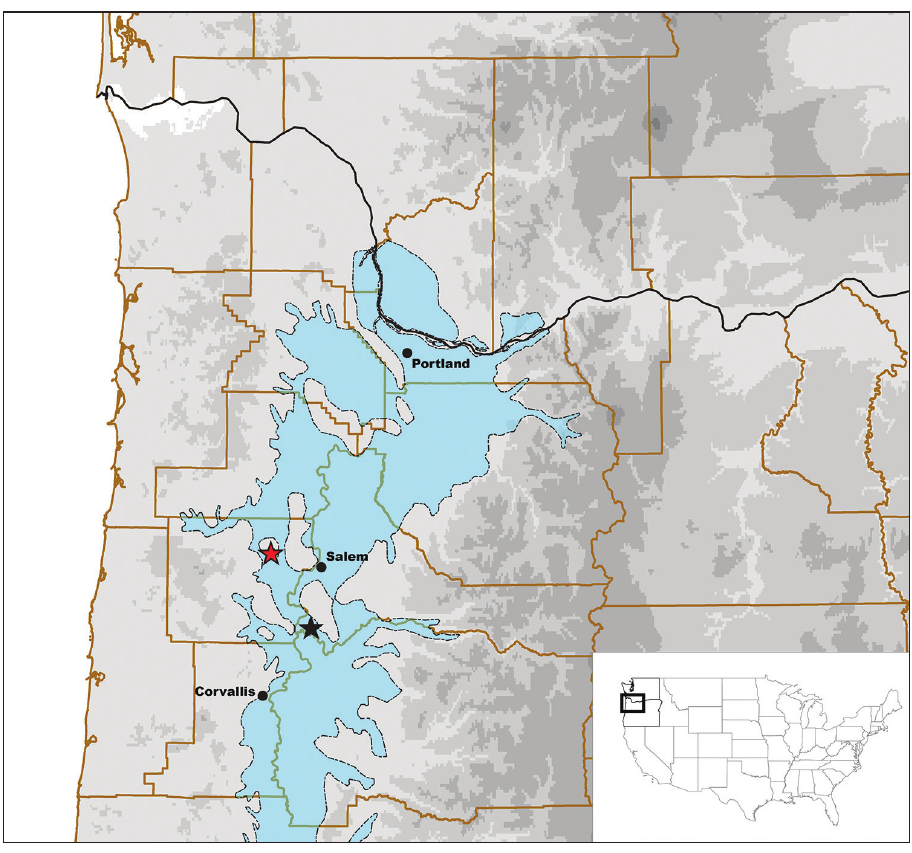
Figure 2. The two known collection localities of Stygoporus oregonensis . Oregon/Washington State boundary in black. County boundaries in brown. Blue shaded region outlined with a dotted line cor- responds to Willamette Lowland basin-fill aquifers. Type locality indicated by red star with black border. New collection locality indicated by black